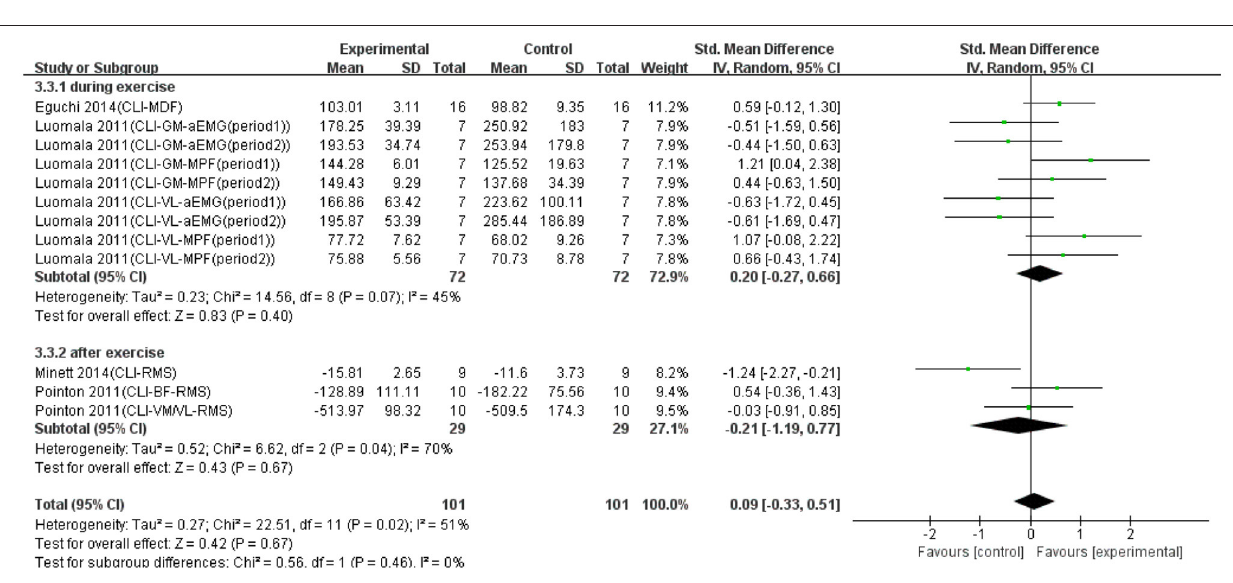
p 0.003; I 2 55%; random effect). When compression was = = applied after exercise, the trend of recovery was non-effective (SMD 0.18; 95% CI 0.46 to 0.09; p 0.19; I 2 0%; = − = − = = random 0.56; 95% CI 0.19 to 0.92; = =